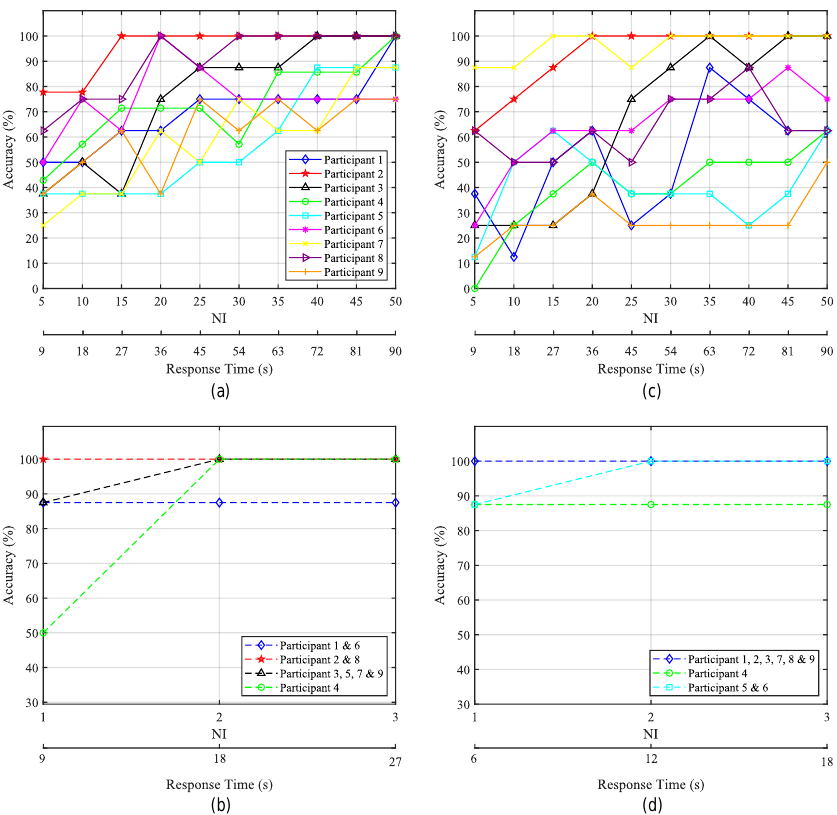
Figure 9. Accuracy obtained for each participant as a function of the elapsed time from the start of the intensifications. ( a , c ) correspond to P300-based experiments while ( b , d ) correspond to blink-based experiments. The left column ( a , b ) shows the results for the 1-by-1 paradigm and the right one ( c , d ) depicts the results for the row/column